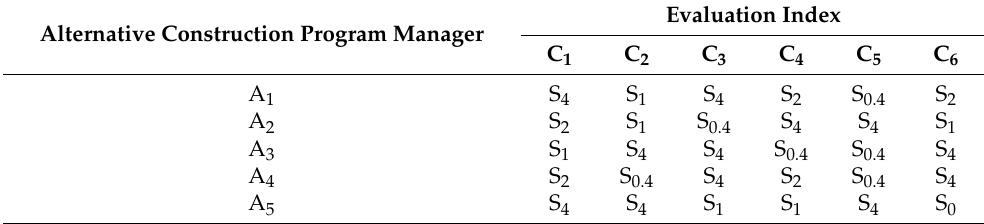
Table 3. Linguistic Multi-attribute Evaluation Matrix X 1 of decision maker D 1 .